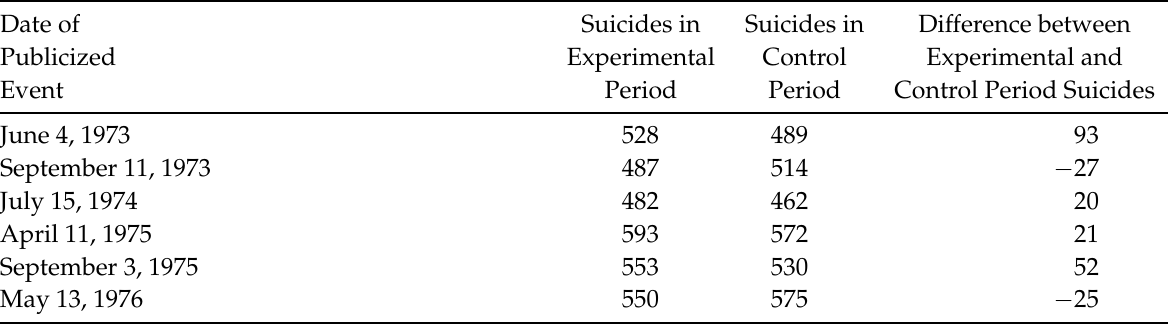
Table 1: Replication of Bollen and Phillips (1982) for the period 1973–1976 Date